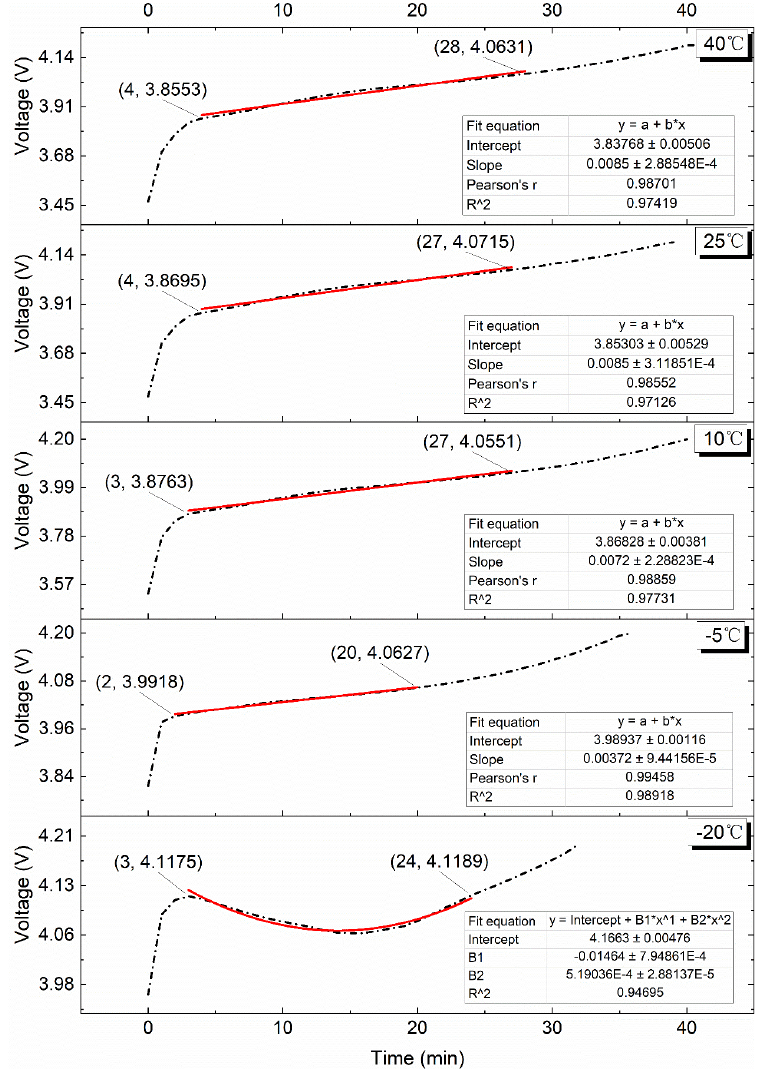
Figure 15. Effect of various temperatures on the VPP at 1.00C charging.